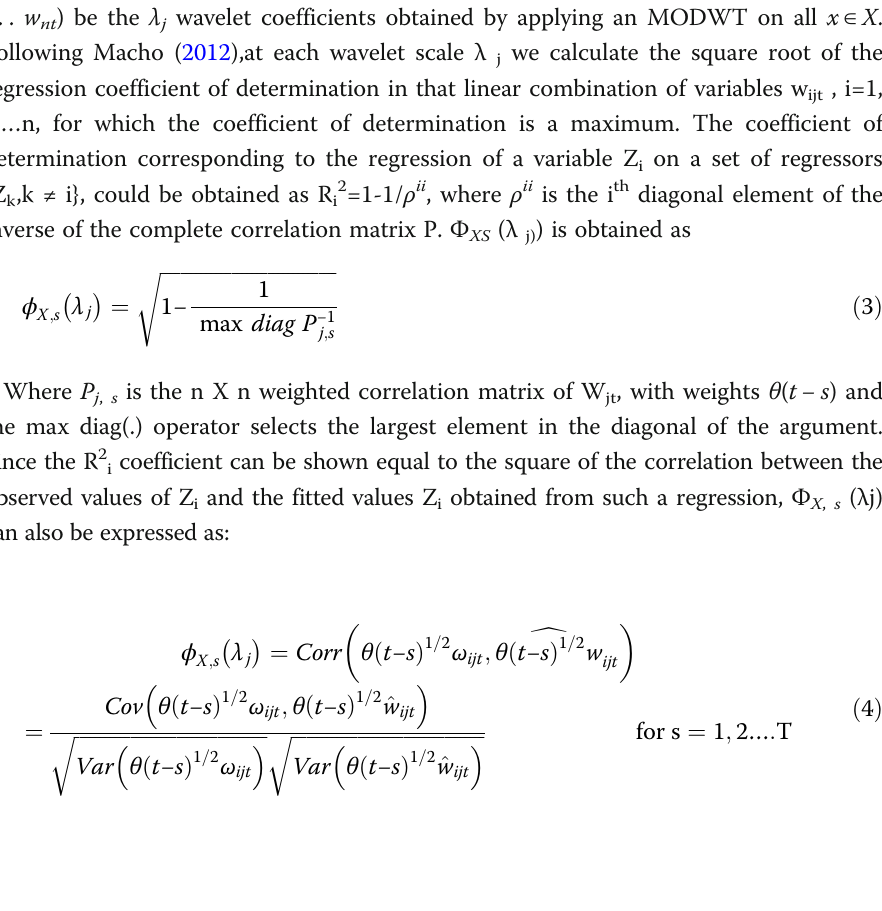
ffiffiffiffiffiffiffiffiffiffiffiffiffiffiffiffiffiffiffi (cid:1) (cid:3)q ffiffiffiffiffiffiffiffiffiffiffiffiffiffiffiffiffiffiffiffiffiffiffi (cid:1) Var ^ w ijt þ τ Var ω ijt